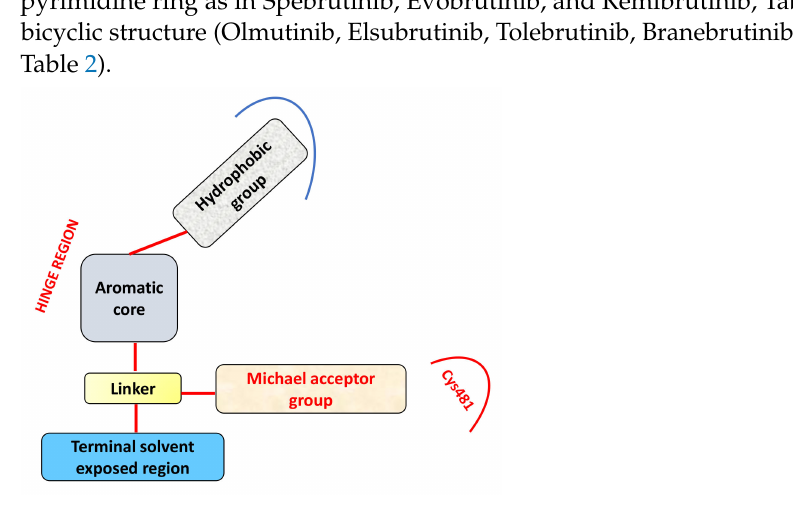
Figure 1. Schematic representation of irreversible BTKIs.